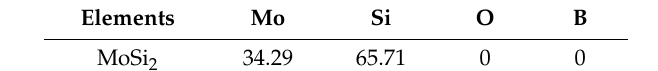
Figure 3. Cross-section morphology of MoSi 2 -ZrB 2 coatings: ( a ) mz40, ( b ) mz43 and ( c ) mz45.